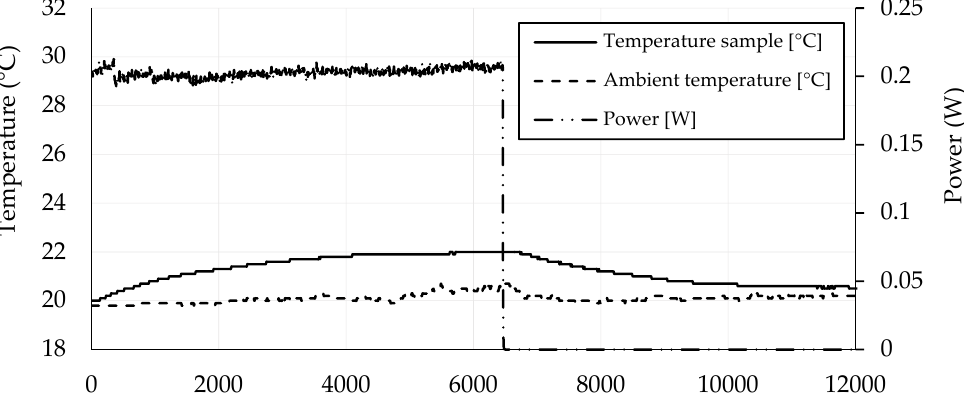
Figure 7. Self-heating experiment—CB 1.5, 40 V.